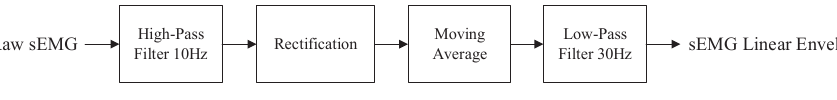
Figure 2. Pipeline for calculating sEMG linear envelope. Modified from [27] with